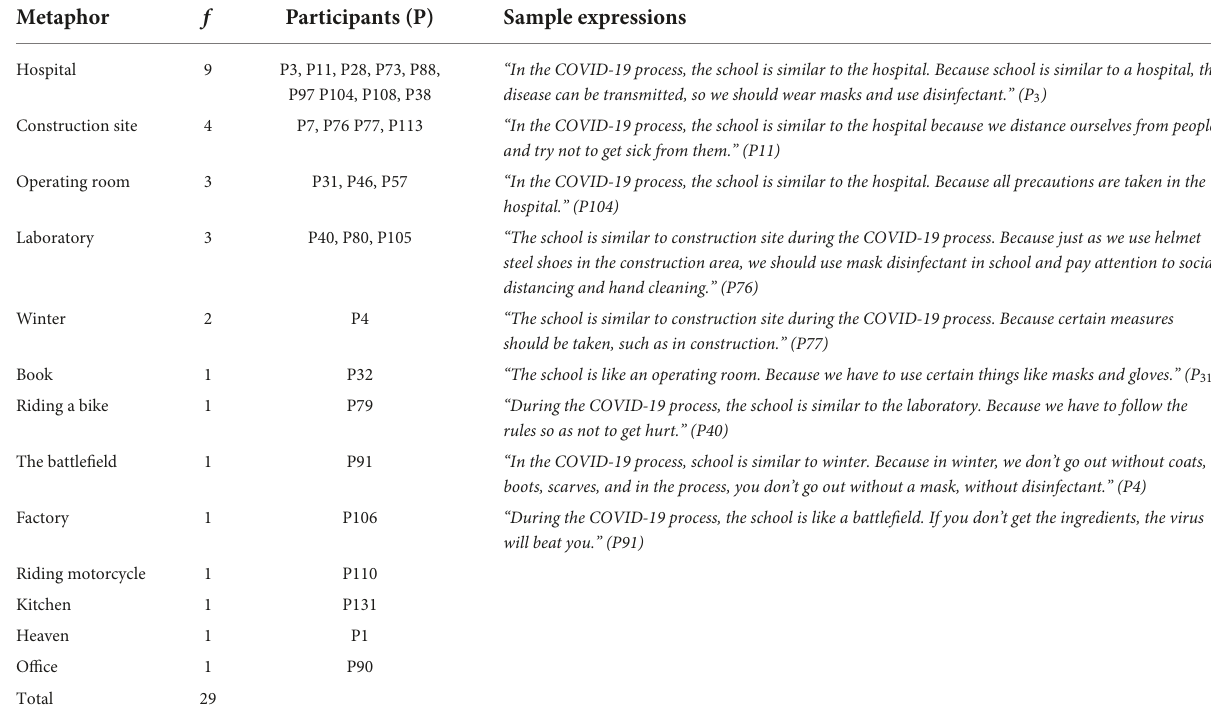
TABLE 14 Take precaution place